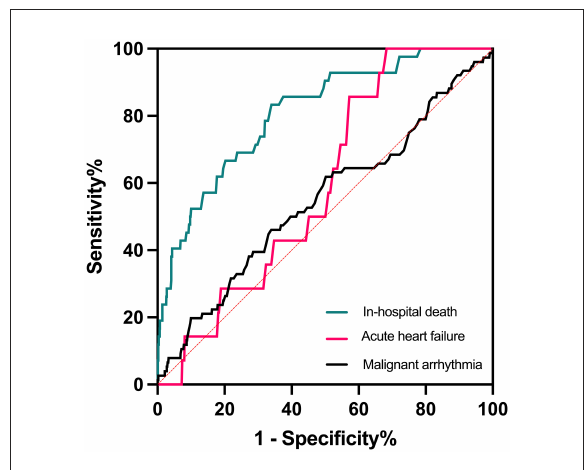
FIGURE1 ROC curves of α -HBDH in predicting in-hospital